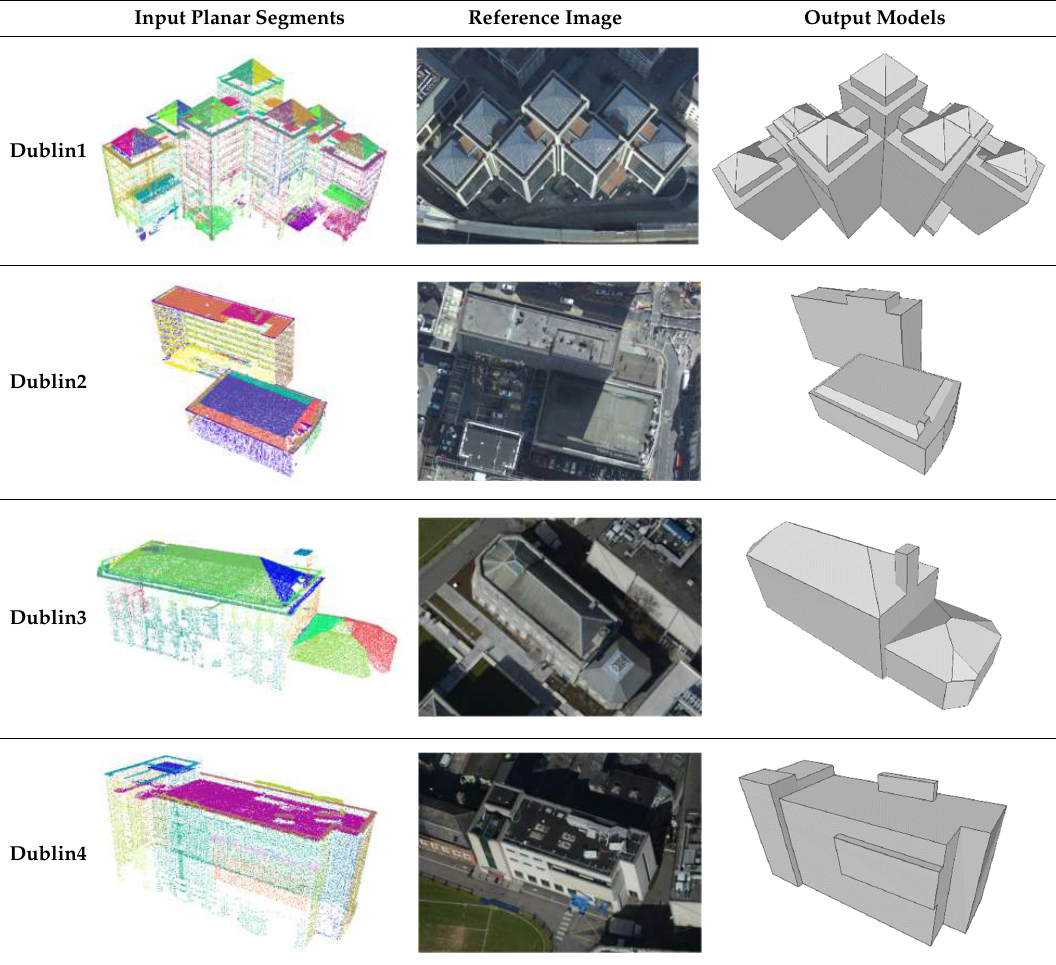
Table 1. Data overview and modeling results.